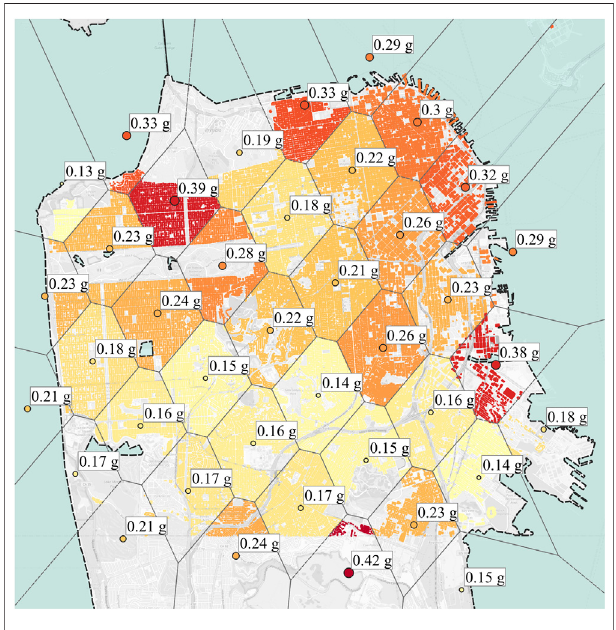
FIGURE 4 | The geographical distribution and PGA values of the considered ground motions in the region.